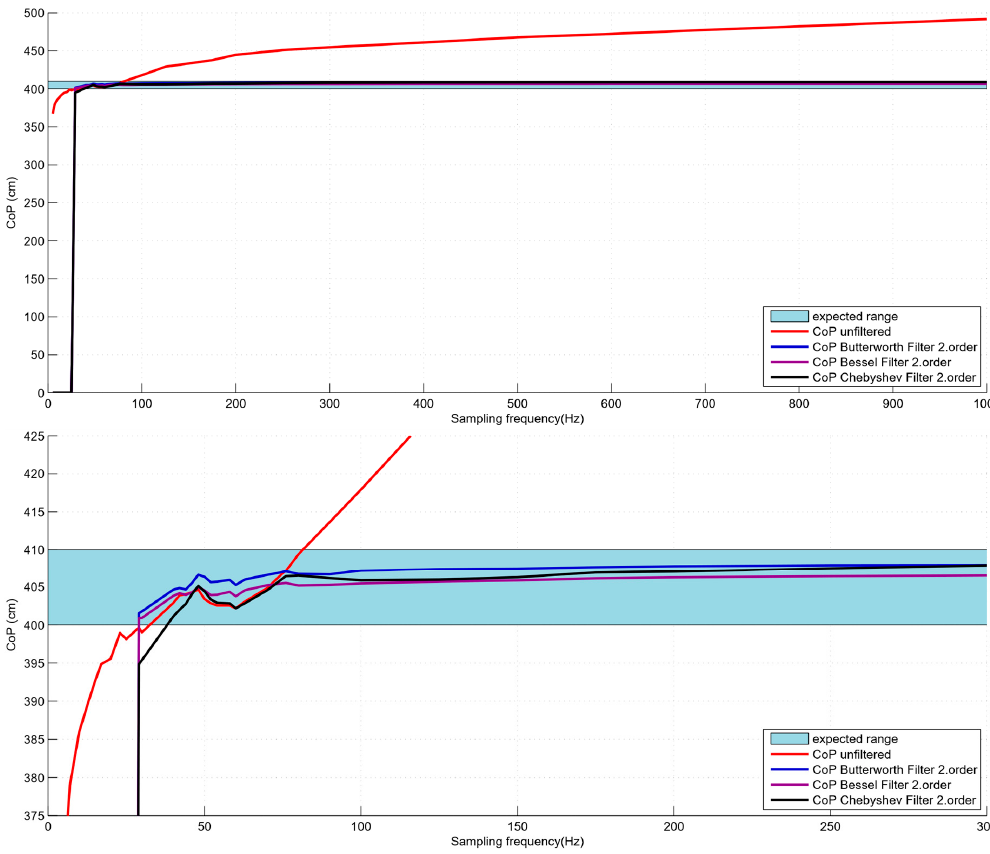
Figure 8. Representation of the effect of the testing frequency on the measurement, with a detailed view of the sampling frequency of 0 Hz and 200 Hz.